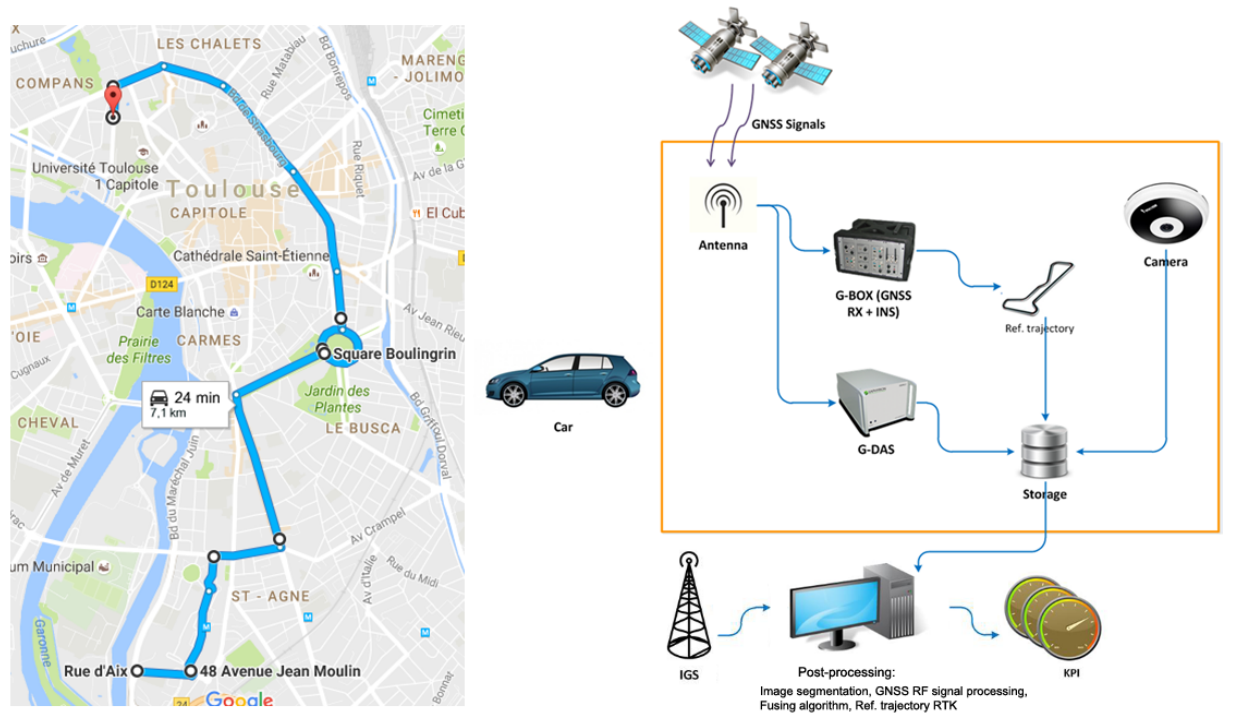
Figure 5. Experimental configuration.